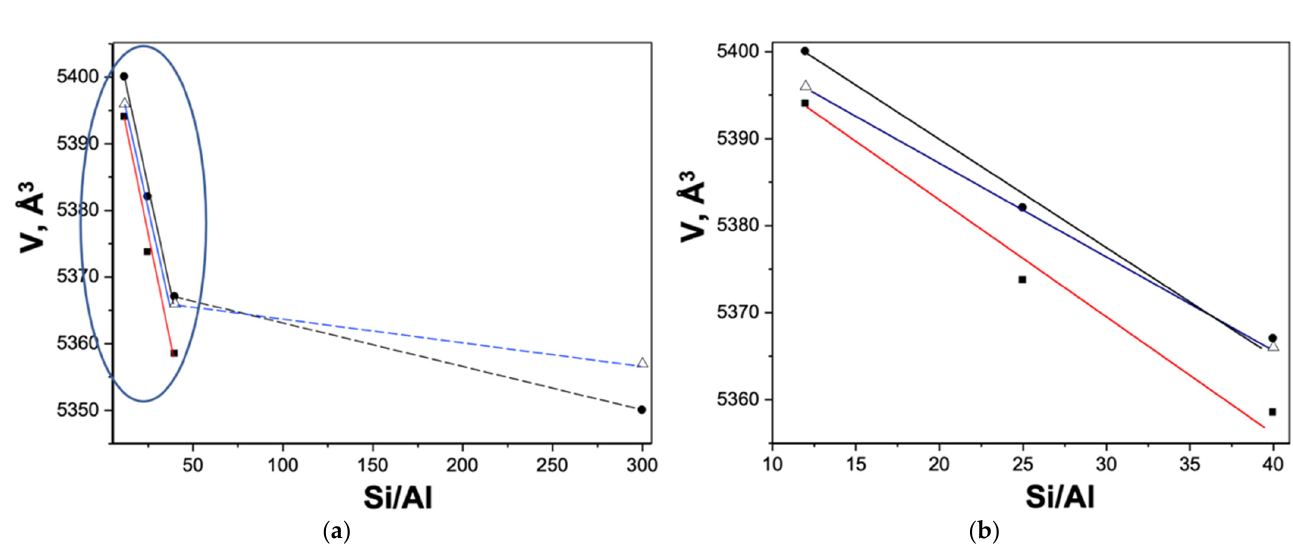
Figure 4. Relationship between HZSM and NA/HZSM silicate module (Si/Al) and unit cell volume (V, Å 3 ): • —HZSM and △ —NA/HZSM ( Method 1 а ) according to data from the ESRF synchrotron; ■ —HZSM according to data from Kurchatov Synchrotron Radiation Source: Si/Al = 12, 40 and 300 ( a ), Si/Al = 12 and 40 ( b ).